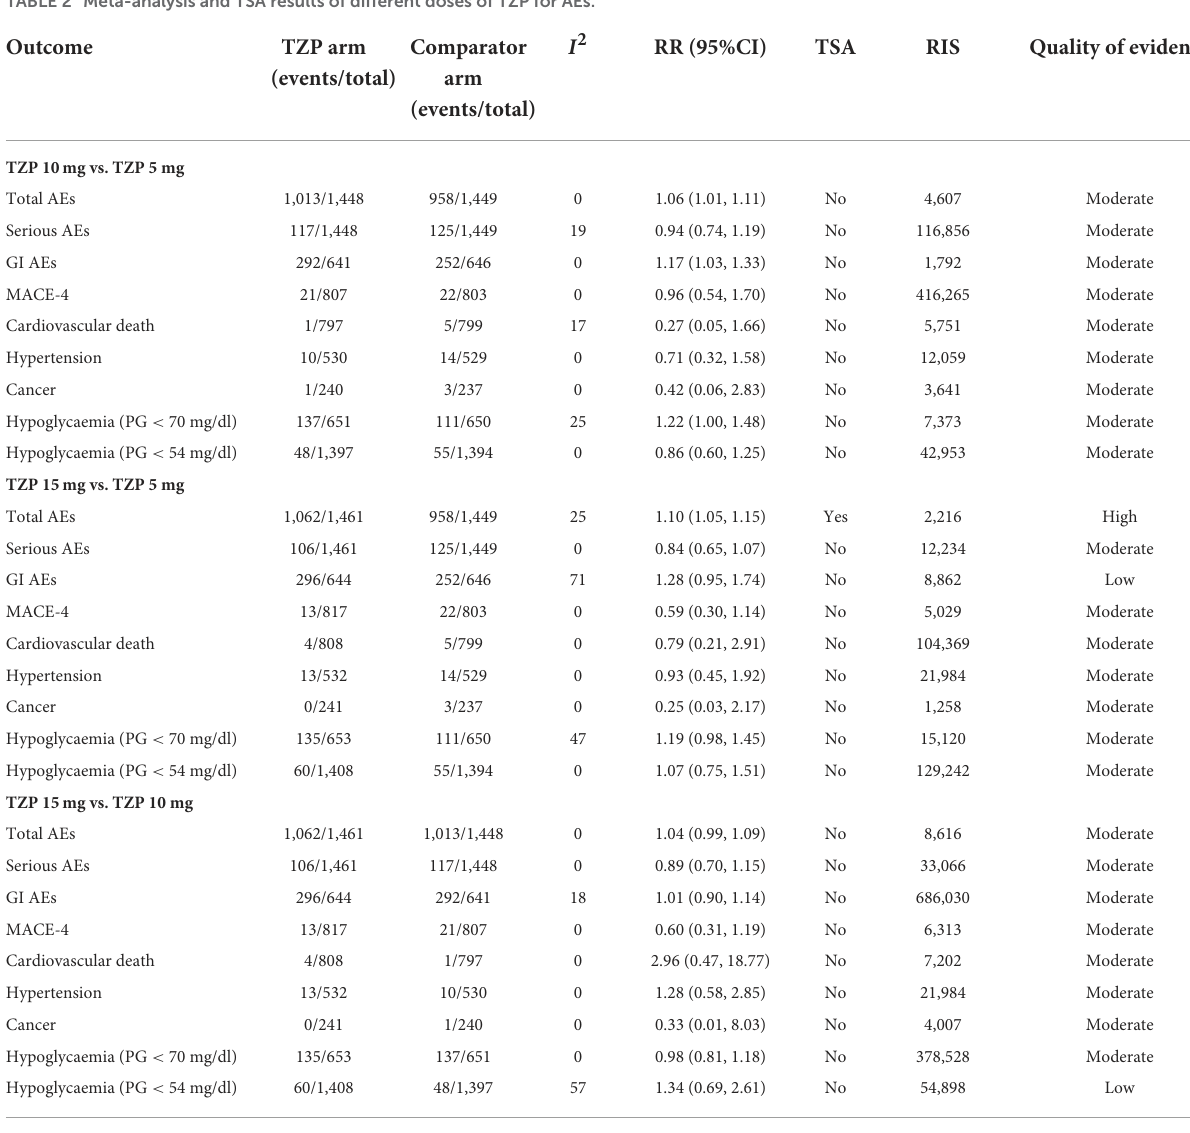
TABLE 2 Meta-analysis and TSA results of different doses of TZP for AEs.